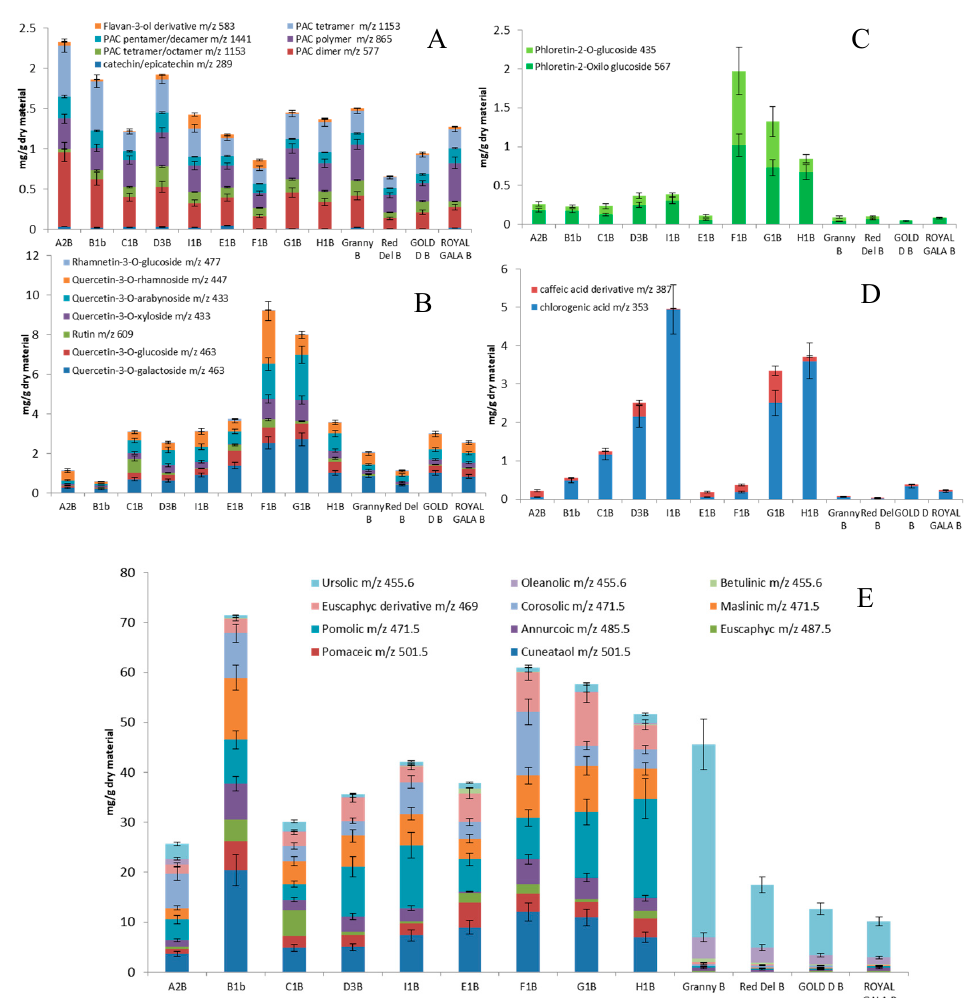
Figure 7. Contents, mg/g on dry material, of flavan-3-ols and procyanidins ( A ), flavonoids ( B ), chalcones ( C ), hydroxycinnamic acids ( D ) and triterpene acids ( E ) in apple peels. In the X axis: Granny: ‘Granny Smith’, Red Del: ‘Red Delicious’, Gold D: ‘Gold Delicious’.